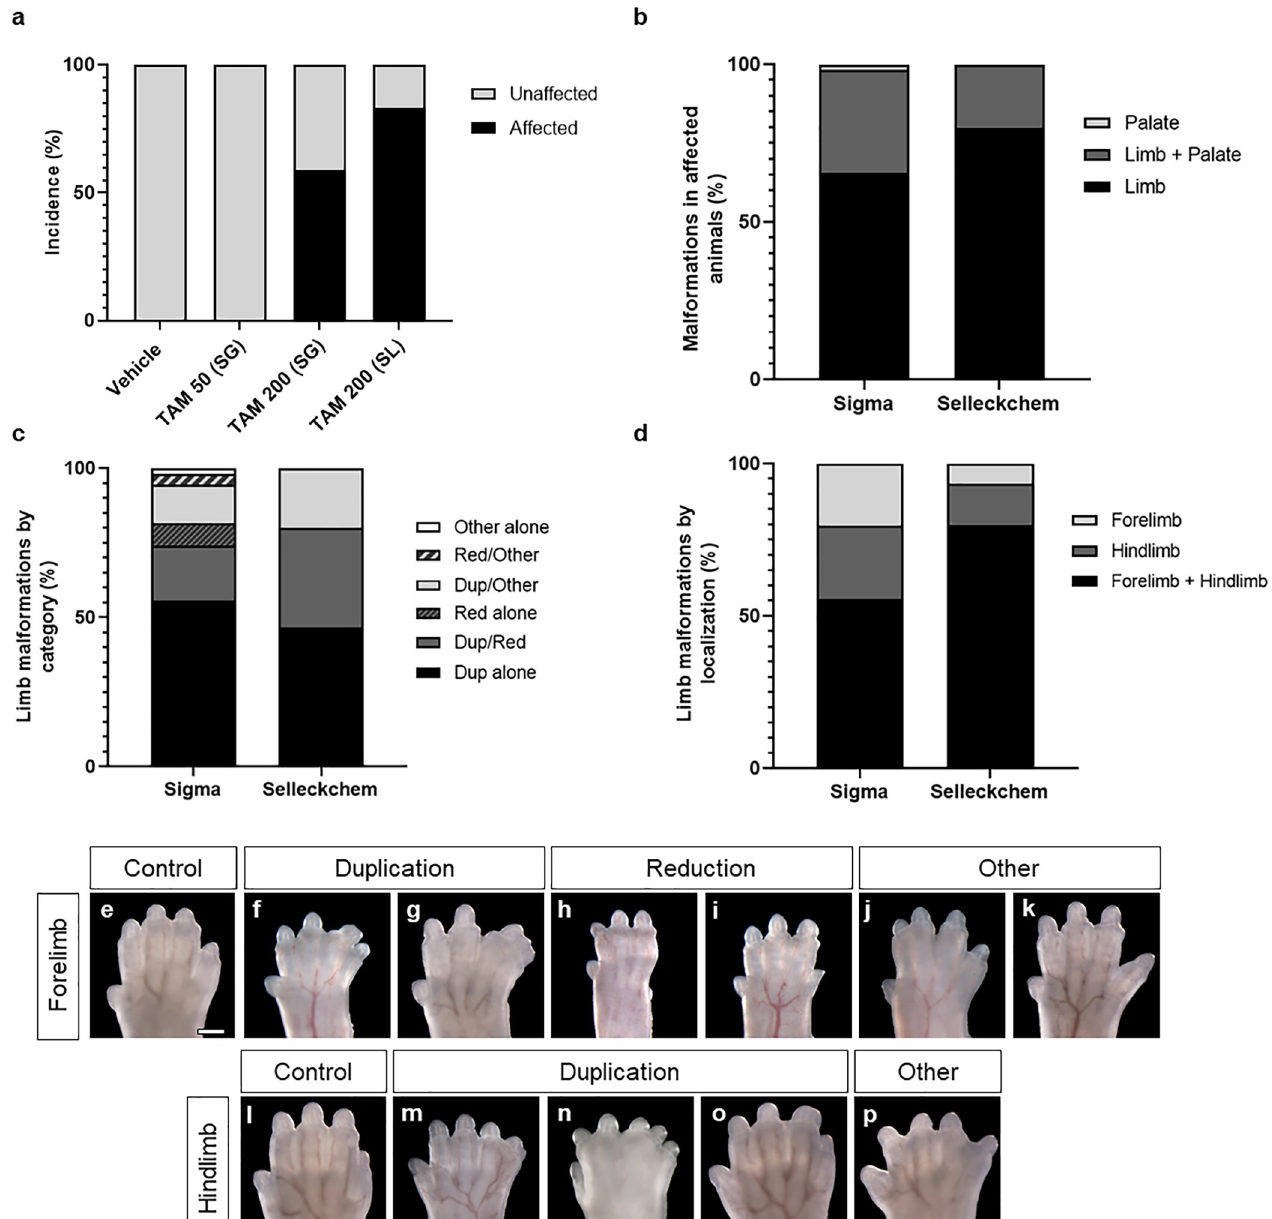
Fig 2. Incidence of tamoxifen-induced limb and craniofacial malformations. The incidence of malformations occurring in animals treated with tamoxifen or vehicle at GD9.75 are summarized (a-d). The percentage of animals displaying at least one structural malformation in each treatment group is shown (a). Structural malformations appeared in animals treated with 200 mg/kg Sigma or Selleckchem tamoxifen, and these affected animals displayed either limb malformations, craniofacial malformations, or co-occurring limb and craniofacial malformations (b). Except for a single animal exhibiting an isolated secondary cleft palate, all affected animals exhibited limb malformations (b). Therefore, limb abnormalities were further classified according to apparent dysmorphology (c) and limb-specific localization of the abnormality (d). Examples of limb morphology in vehicle controls and tamoxifen-treated animals (e- p). A duplication phenotype was assigned to limbs that exhibited an extra posterior digit with or without cutaneous fusion to adjacent digits in both forelimbs (f, g) and hindlimbs (m, n, o). Posterior digit reduction phenotypes were exclusive to forelimbs and included apparent absence of a 5 th digit (h), or a shortening of the 5 th digit (i). Non-reduction/duplication phenotypes included apparent hyperplasia of interdigital tissue between the 2 nd and 3 rd forelimb digits (j) and laterally displaced 5 th digits in forelimbs (k) and hindlimbs (p). Scale bar in a: 0.5 mm. TAM, tamoxifen; SG, Sigma; SL, Selleckchem; Dup, duplication; Red,